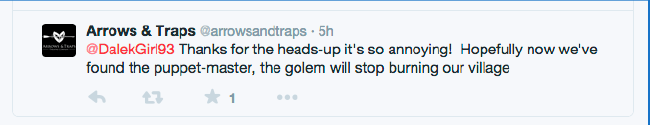
Figure 2. Tweet to @TwasFletcher from @arrowsandtraps.